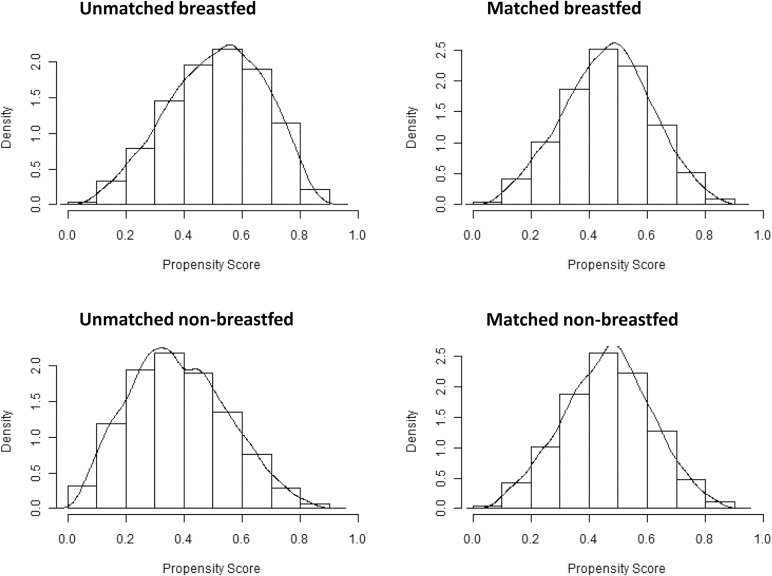
Distribution of propensity scores before and after matching.Distribution of propensity scores with overlaid kernel density estimate of study participants in the breastfed and non-breastfed groups before and after the matching procedure.